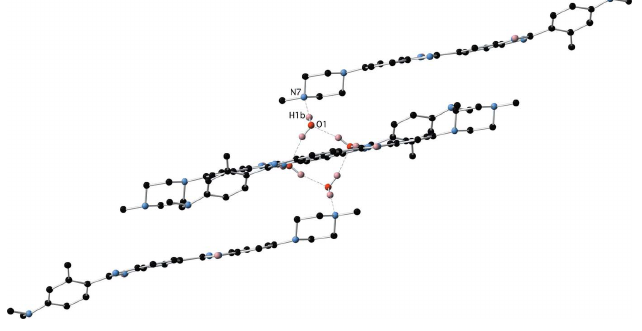
Figure 5 The water tetramer with additional hydrogen-bonded interactions with (1).